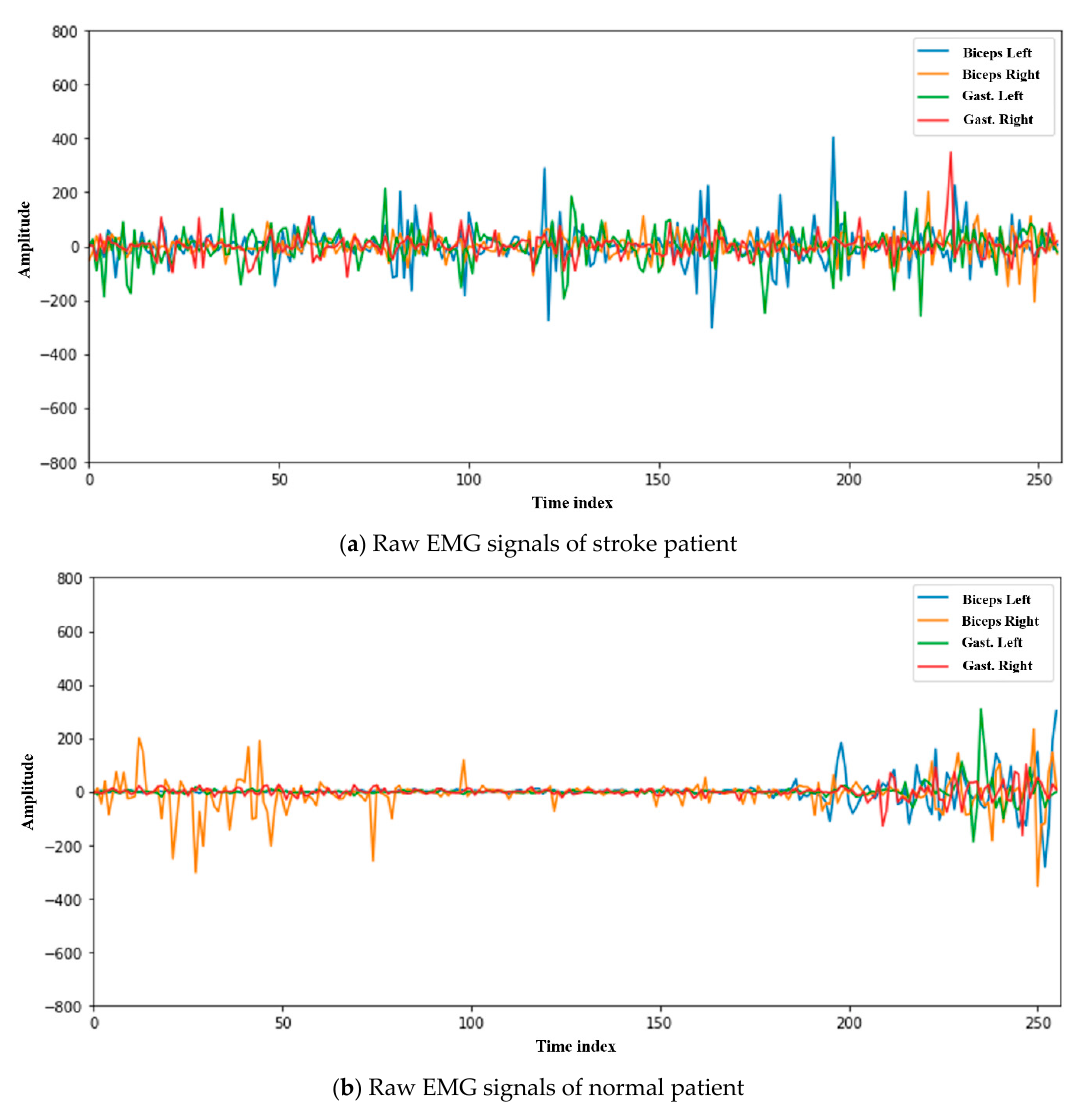
Figure 4. Example of EMG bio-signals waveform changes while walking. ( a ) stroke patient sample, ( b ) normal sample.